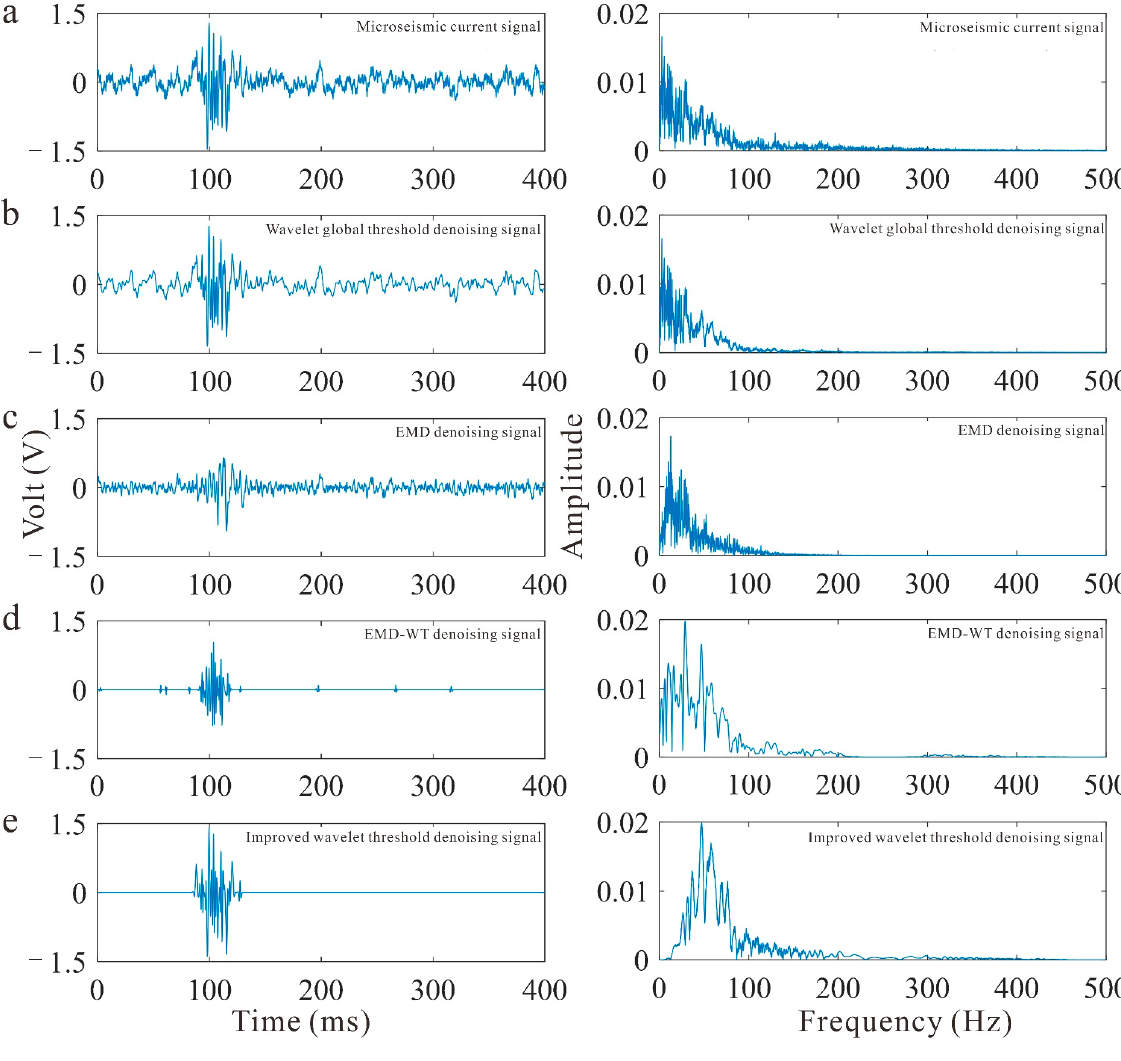
Figure 13. Comparison of denoising effects for an actual microseismic current signal: ( a ) microseismic current signal, ( b ) Wavelet global threshold denoising signal, ( c ) EMD denoising signal, ( d ) EMD-WT denoising signal, ( e ) improved wavelet threshold denoising signal.